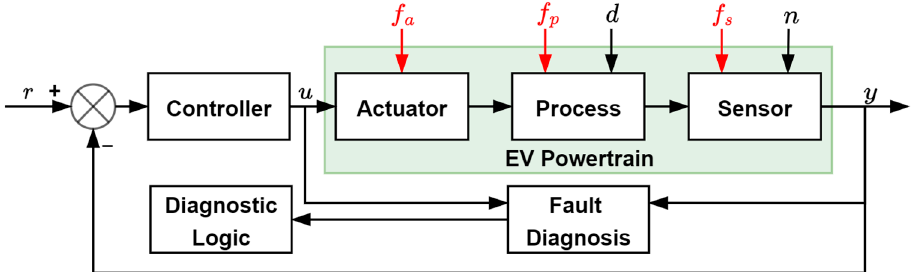
Figure 4. Scheme of fault diagnosis in an EV powertrain.